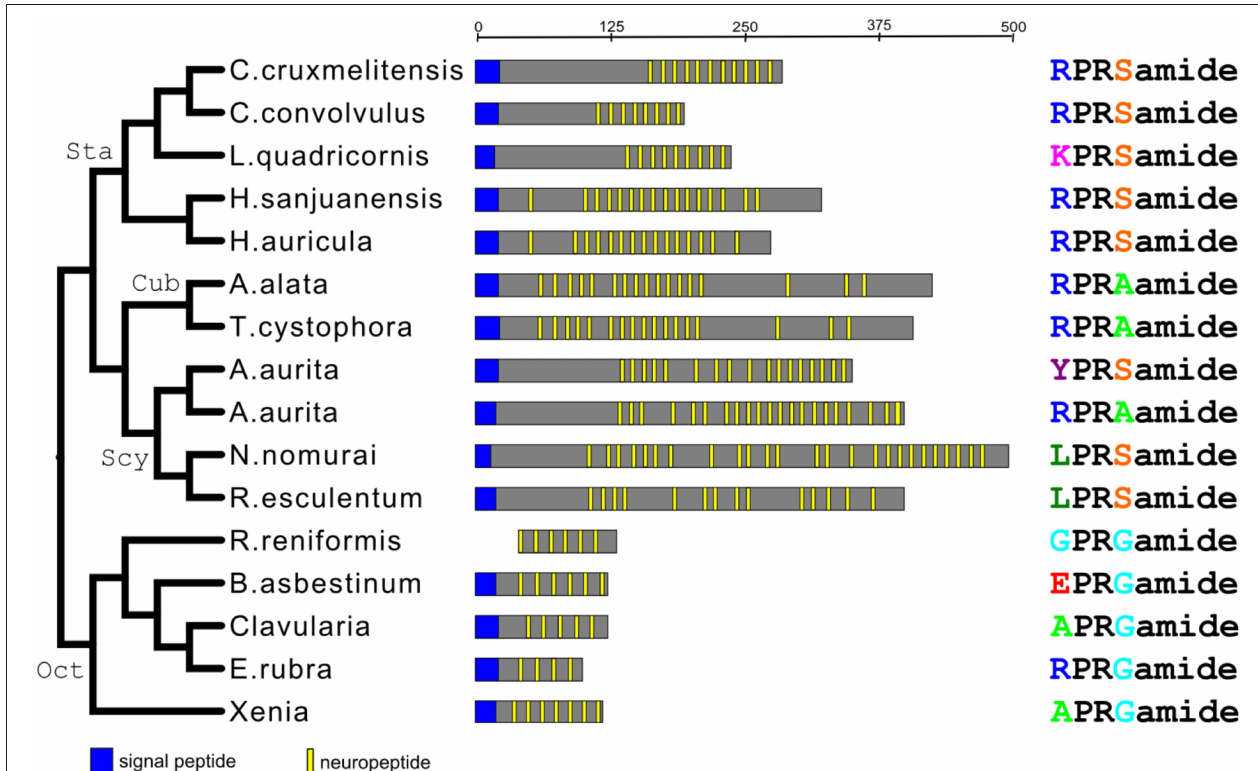
FIGURE 3 | Phylogenic tree analysis of all the identified X 1 PRX 2 amide preprohormones from scyphozoans, staurozoans, cubozoans, and octocorallians. This phylogenetic tree (left panel) is in complete accordance with the phylogenetic tree given in Figure 1 . The abscissa (upper line) gives the length of the preprohormone fragments (in amino acid residues). The middle panel gives schematic representations of the various preprohormones from each species. The right panel gives the amino acid sequences of the major X 1 PRX 2 amide peptides produced by these preprohormones. This panel also shows that X 1 PRX 2 amide (where X 2 is either S, A, or G) is the consensus sequence of all peptides. ( Table 4 , neuropeptide family #6). The C-termini from the GLWamides are relatively well-conserved, but their N-termini are quite variable [see Table 1 from Nielsen et al. (31)]. The same is true for the GRYamide peptides